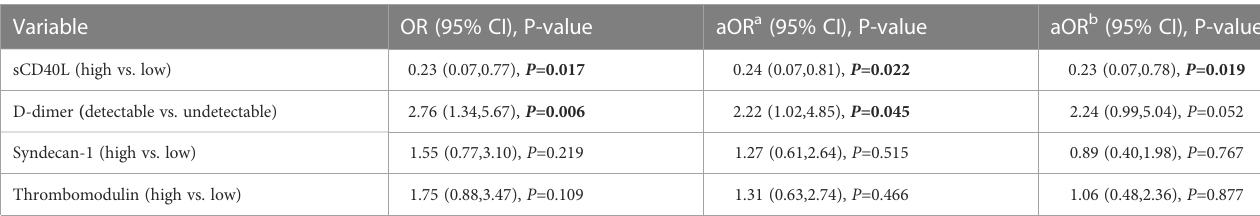
TABLE 2 Associations between AA and high levels of the biomarkers.